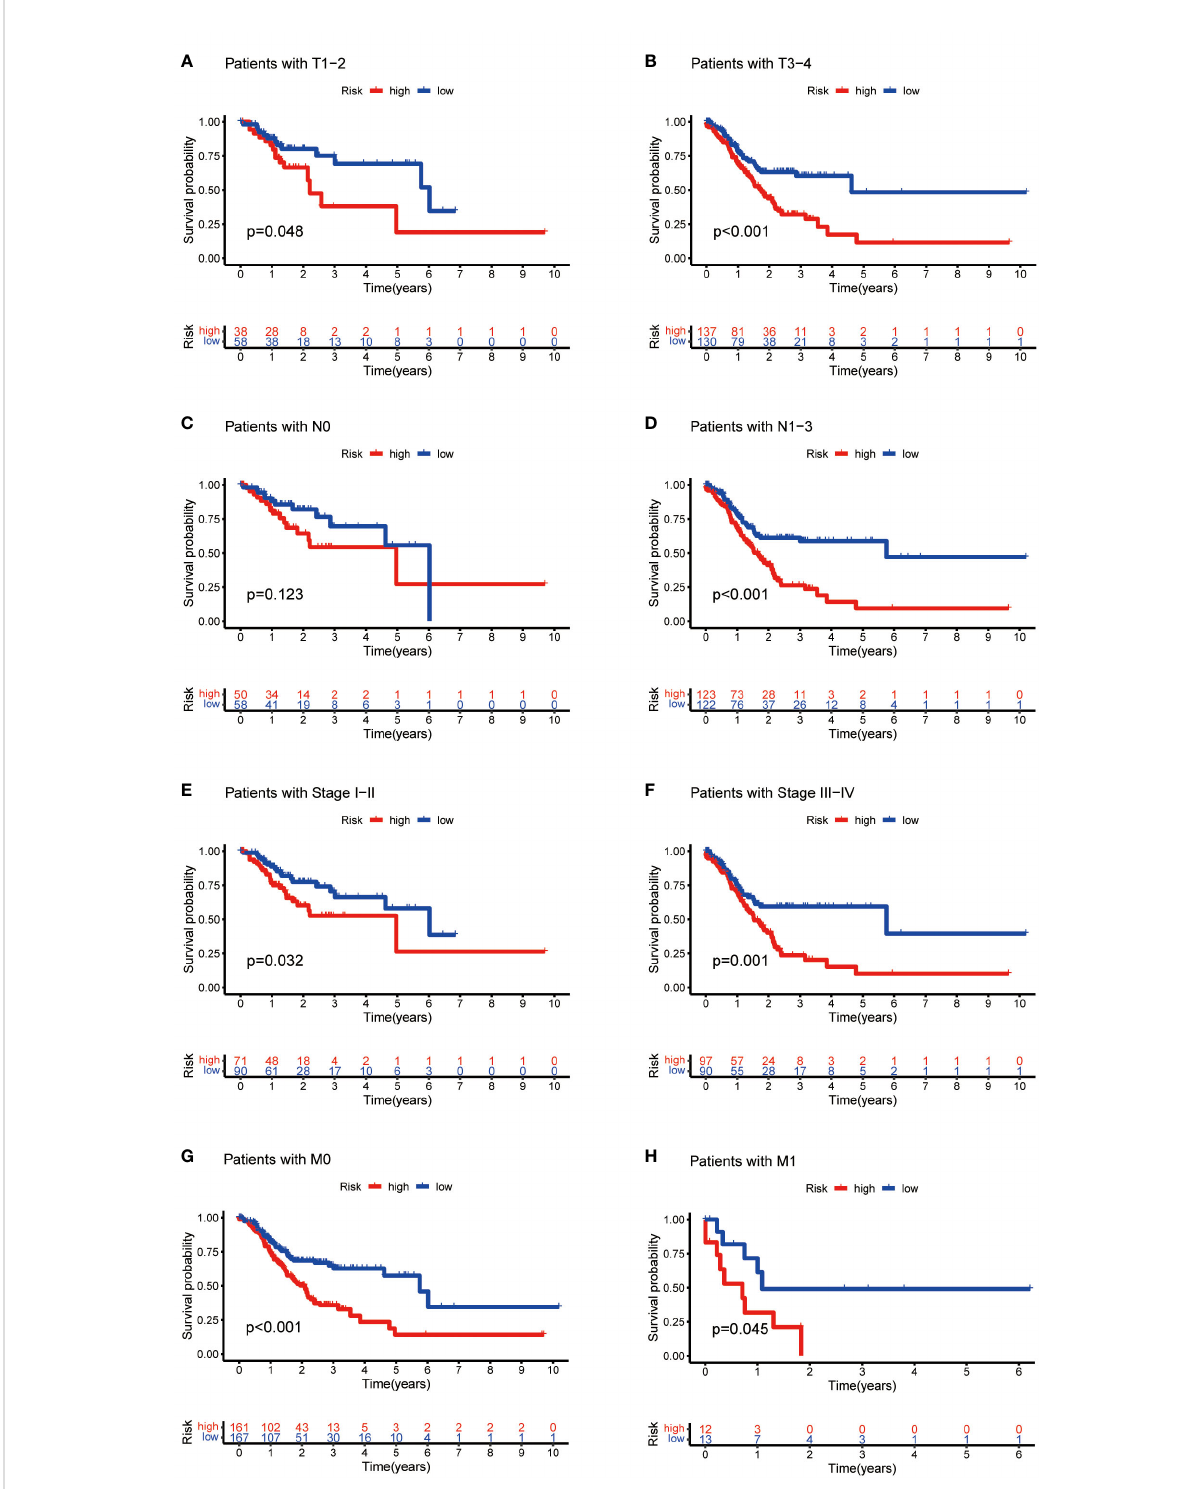
FIGURE 8 Kaplan-Meier curves of OS differences strati fi ed by tumor invasion depth (T), lymph node matestasis (N), distinal metastasis (M) and TNM staging between the high- and low-risk